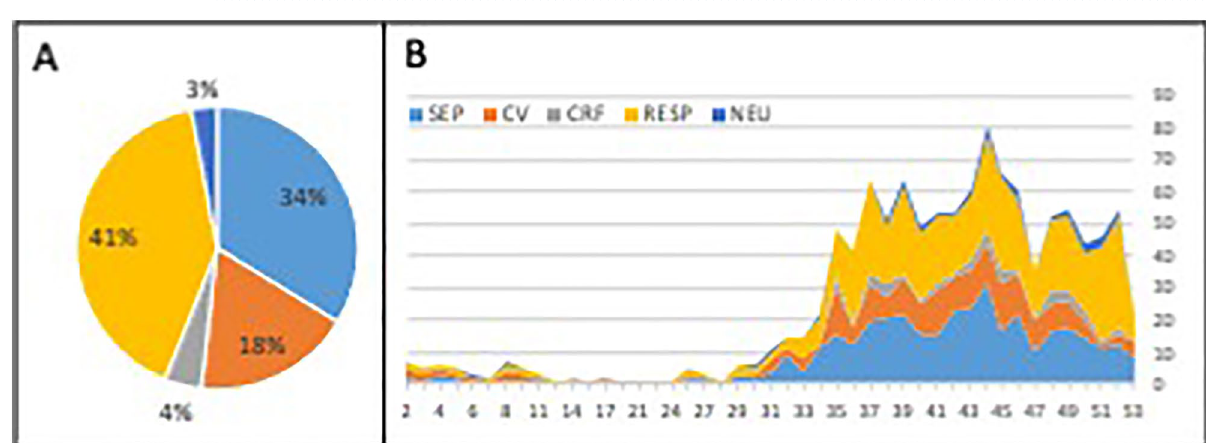
Figure 3. Major cause of death. Pie plot with overall distribution ( A ) and time-based evolution during the study ( B ; X-axis—study inclusion week, Y-axis—absolute number of patients) is presented for the following causes of death: sepsis and multi-organ failure (SEP, blue), cardiovascular failure (CV, orange), cardio- respiratory failure (CRF, grey), respiratory failure (RESP, yellow), neurological cause (NEU, dark